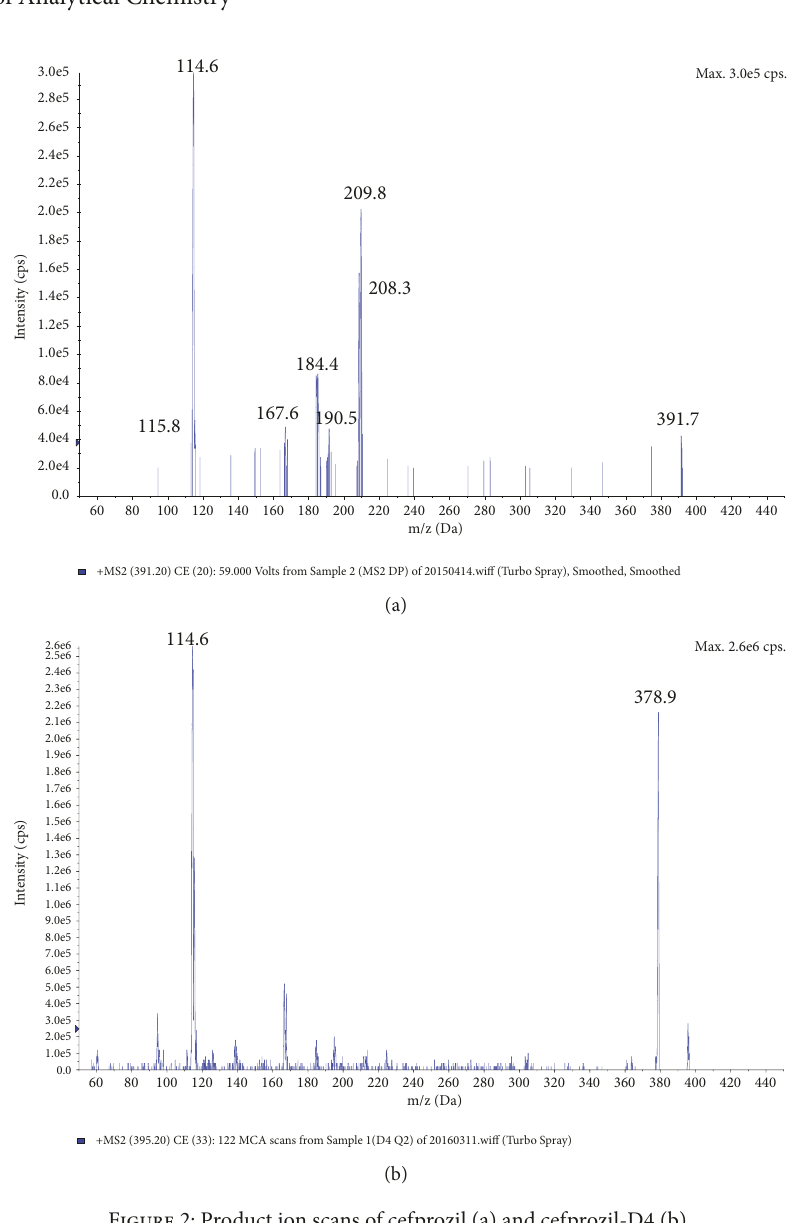
Figure 2: Product ion scans of cefprozil (a) and cefprozil-D4